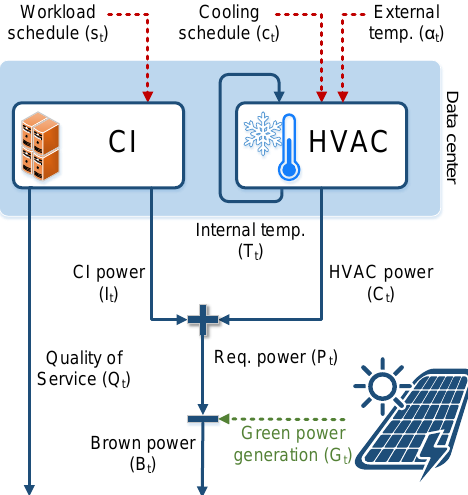
Figure 1. Data center scheme considering energy consumption and quality of